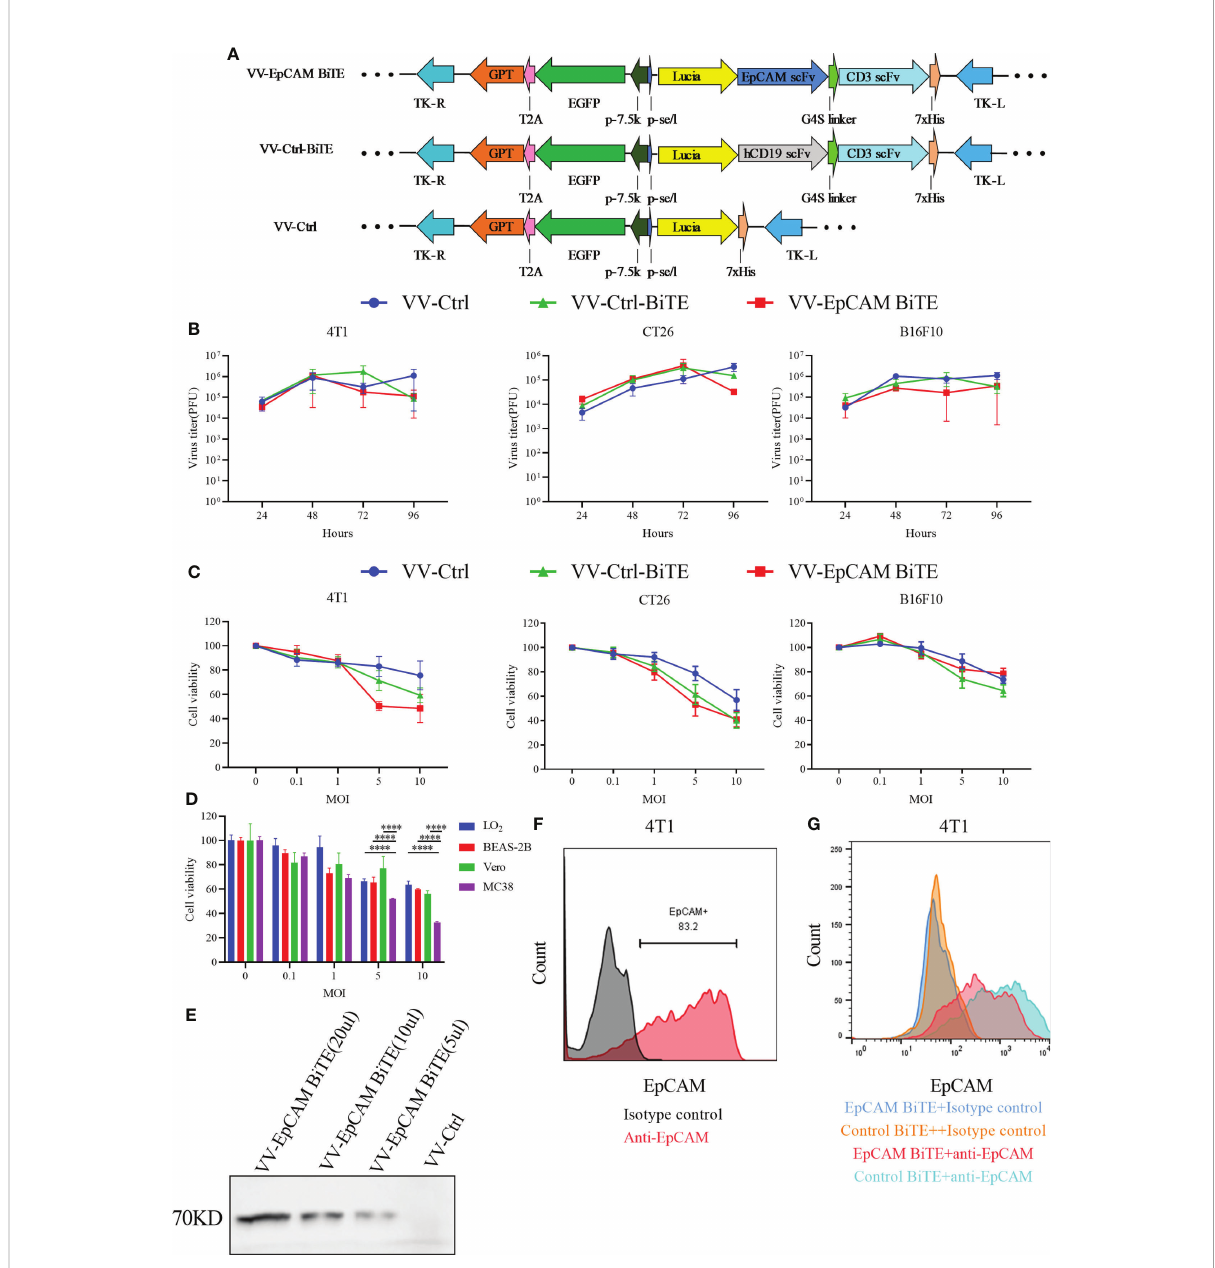
FIGURE 1 The construction and characterization of VV-EpCAM BiTE. (A) Schematic structure of recombinant vaccinia viruses. (B) Replication kinetics of VVs. 4T1, CT26, and B16F10 cells were infected with VV-Ctrl, VV-Ctrl-BiTE, or VV-EpCAM BiTE at an MOI of 1. Cells were harvested at 24, 48, 72, and 96 hours, and the virus titer was detected by titration assays in HEK 293 cells. All data are presented as means± SEM (n=3). (C) Cytotoxic effects of VVs. 4T1, CT26 and B16F10 cells were infected with VV-Ctrl, VV-Ctrl-BiTE, or VV-EpCAM BiTE at the indicated MOIs. Cell viability was analyzed by MTT assay after 72 hours. All data are presented as means± SEM (n=3). (D) Cytotoxic effects of VV-EpCAM BiTE. MC38, Vero, LO2 and BEAS-2B cells were infected with VV-EpCAM BiTE at the indicated MOIs. Cell viability was analyzed by MTT assay after 72 hours. All data are presented as means± SD (n=3). (E) Expression and secretion of EpCAM BiTE from infected HEK293 cells. Anti-His-tag was used for western blotting. (F) Flow cytometry analysis of EpCAM expression on the surface of 4T1 cells. (G) Binding to 4T1 cells. 4T1 cells were incubated with supernatants harvested from VV- EpCAM BiTE- or VV-Ctrl-BiTE-infected HEK293 cells. Competitive inhibition of anti-EpCAM antibody binding by secreted EpCAM BiTE detected by fl ow